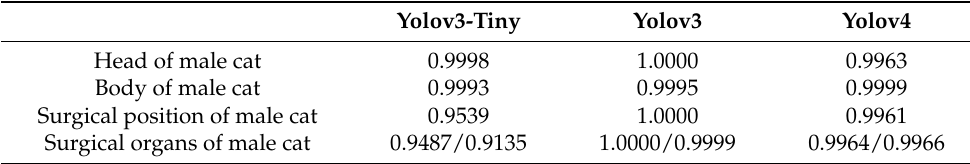
Table 6. Detection performance for male